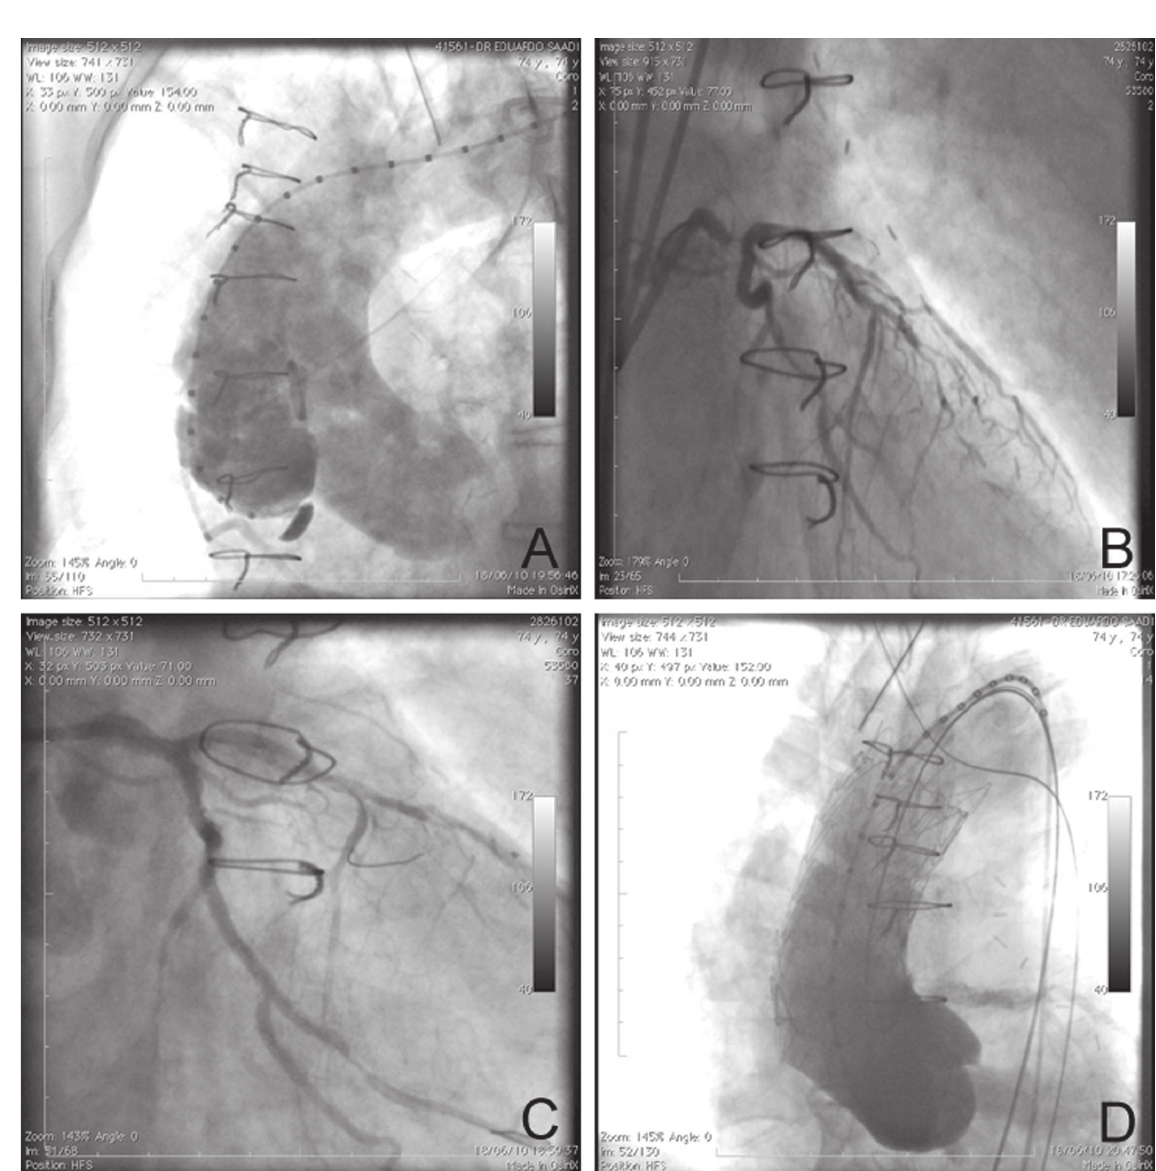
Fig. 2 – A: Aortography shows ascending aorta pseudoaneurysm. B: Severe stenosis of left main artery and lesion in circumflex artery. C: Two drug eluting stents implanted in left main artery and one in circumflex artery. D: Final aortogram shows Gore - Tex™ (W. L. Gore and Associates, Flagstaff, AZ)TAG endoprosthesis after